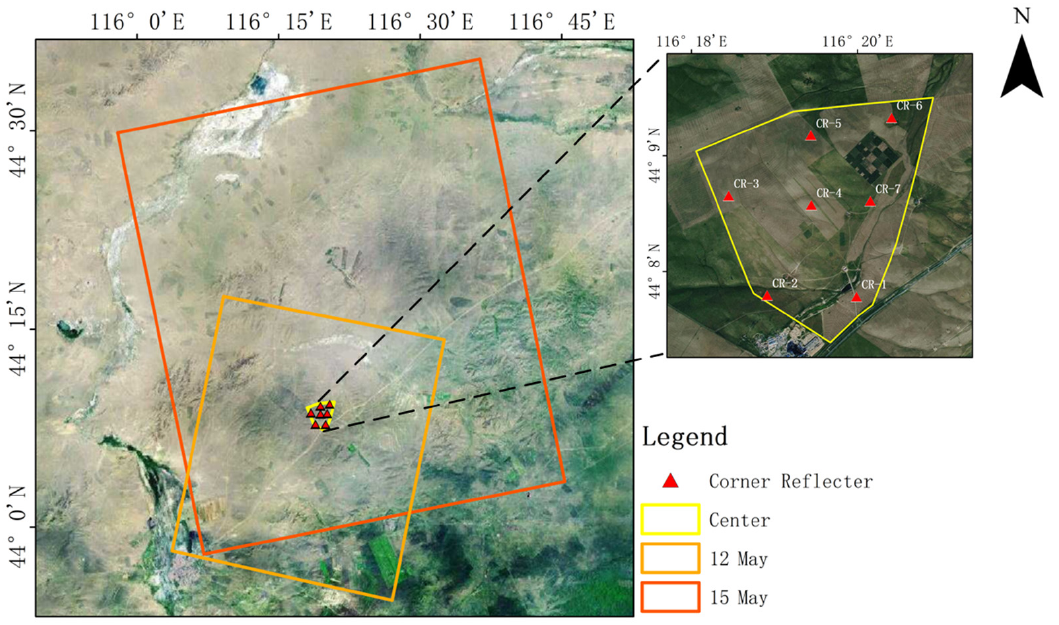
Figure 1. Experimental scope and the coverage of two C-SAR/01 images. The yellow, orange, and red lines represent the coverage areas of the Xilinhot Climate Observatory, the image acquired on 12 May, and the image acquired on 15 May. The red triangles represent CRs. Table 1. C-SAR/01 imaging